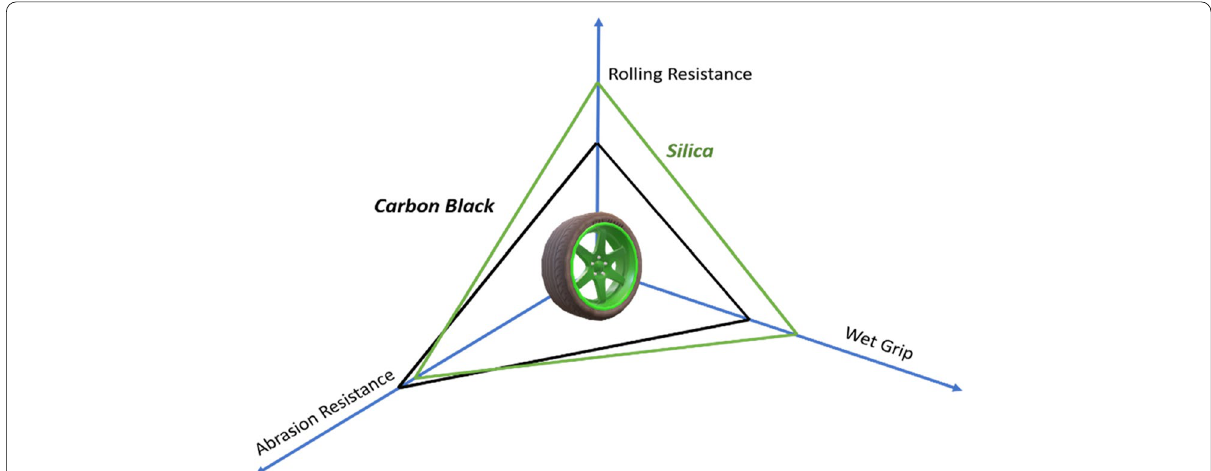
Fig. 1 Magic triangle ‑ performance comparisons between silica and carbon black filled